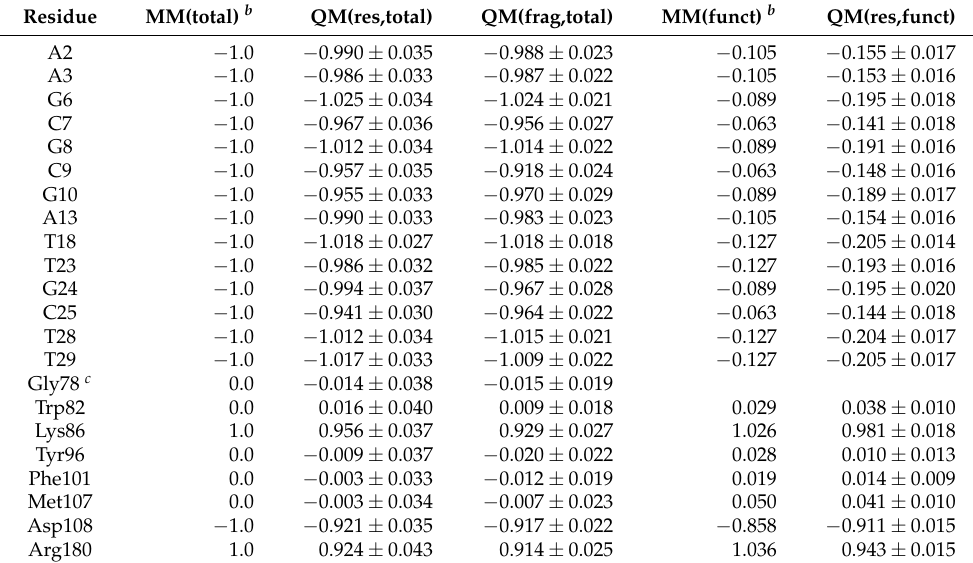
Table 2. Charges (a.u.) of residues averaged in MD a .